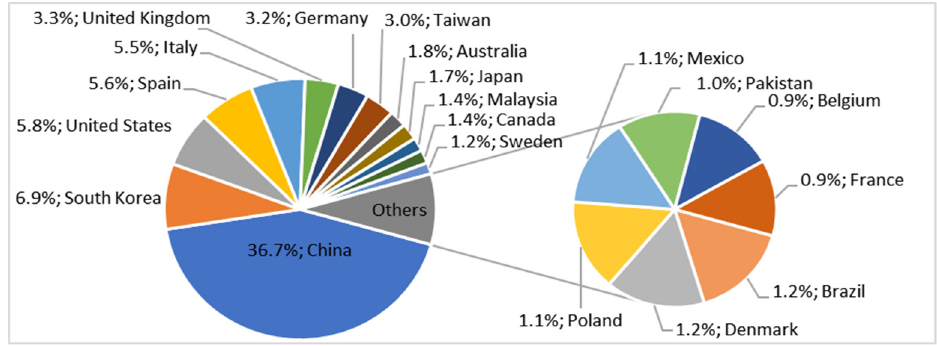
Figure 26. Author distribution by top 20 countries (85.16% of the total).